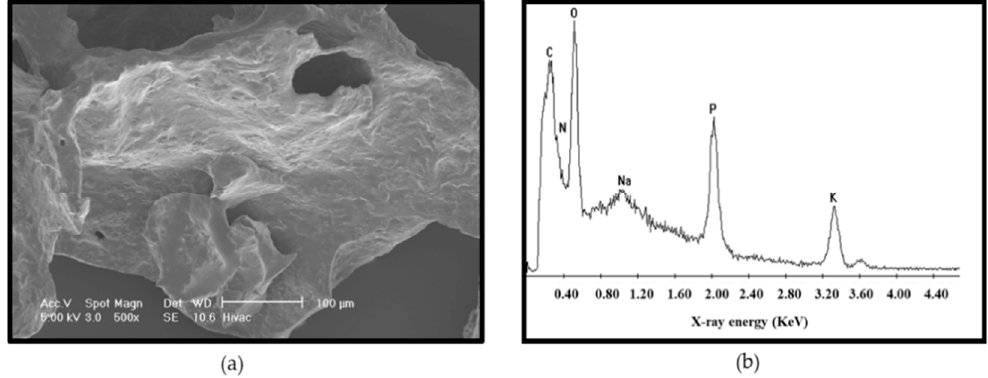
Figure 4. A SEM analysis (500 × ) of the purified EPS ( a ). The cell culture was pelleted by centrifugation after which the EPS was precipitated, dialysed and treated with pronase to remove cell-associated proteins. The material was freeze dried and stored at − 85 ◦ C. Panel ( b ) shows the trace of energy dispersive x-ray elemental analyses of the purified EPS of L. monocytogenes .